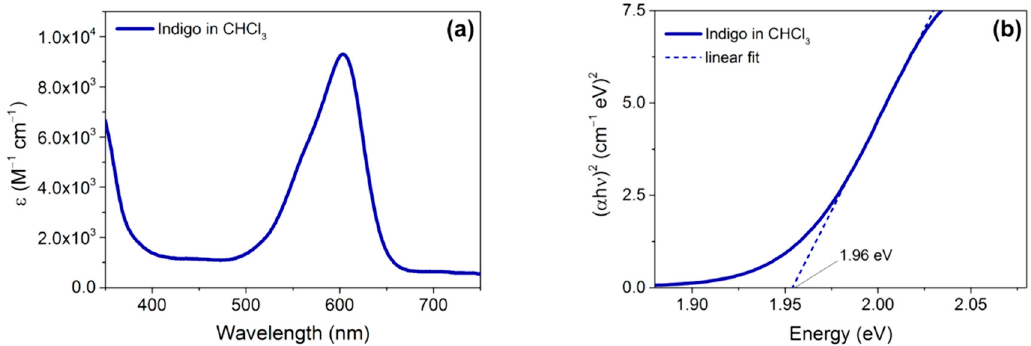
Figure 4. UV-Vis absorption spectrum of indigo dissolved in CHCl 3 ( a ) and corresponding Tauc plot ( b ).